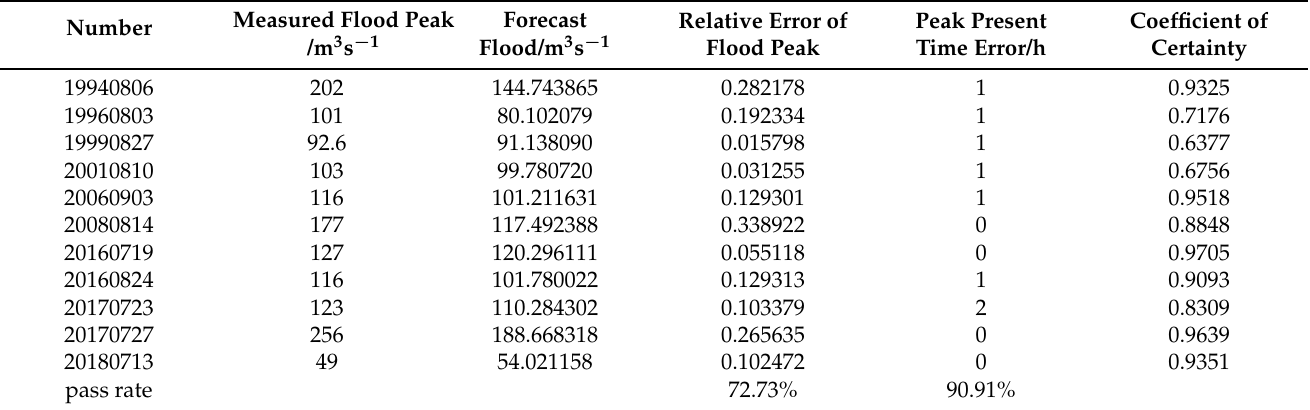
Table 3. Analysis of random forest prediction